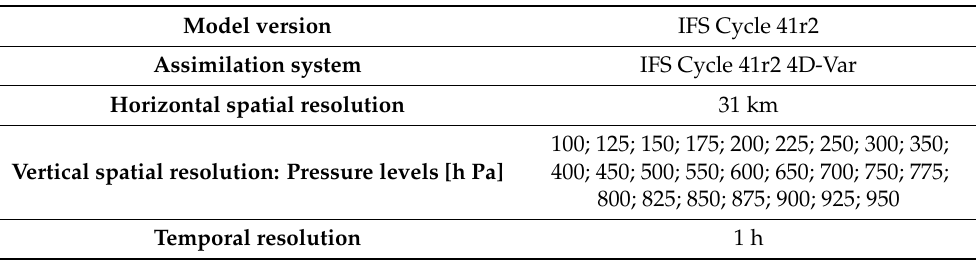
Figure 11. Evolution of the ECMWF estimated relative wind speed and measured wind speed vs. altitude. The relative wind speed estimation is obtained by adjusting the absolute wind speed estimations from the ECMWF ERA5 database with speed data from the balloon GPS. The black dots represent the relative wind speed estimation and the orange dots represent the measured wind speed. The 3 ‐ min. average, together with the standard deviation, are shown for both variables. Table 5. Characteristics of the ERA5 dataset used to obtain the estimated wind speed